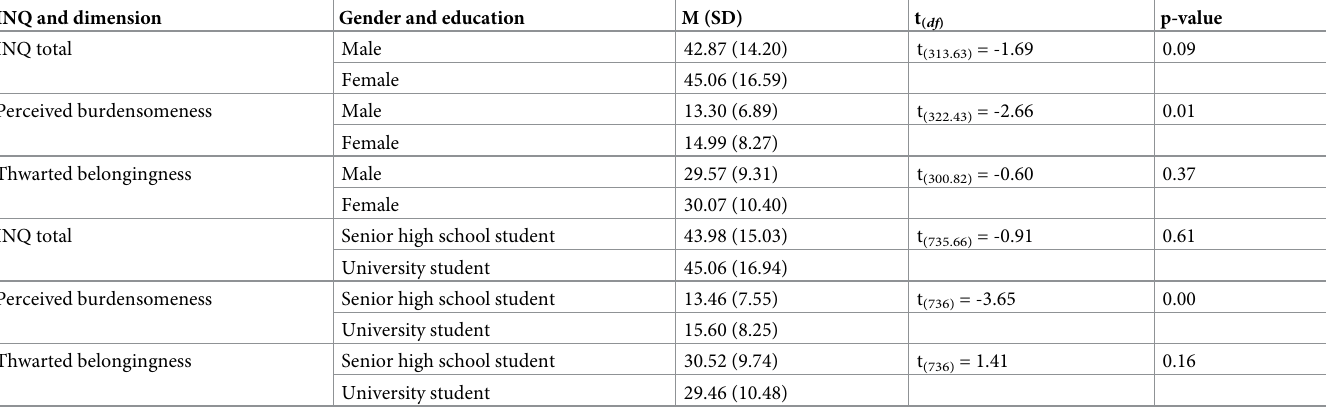
Table 1. Mean, standard deviation, and the t-test comparison. INQ and